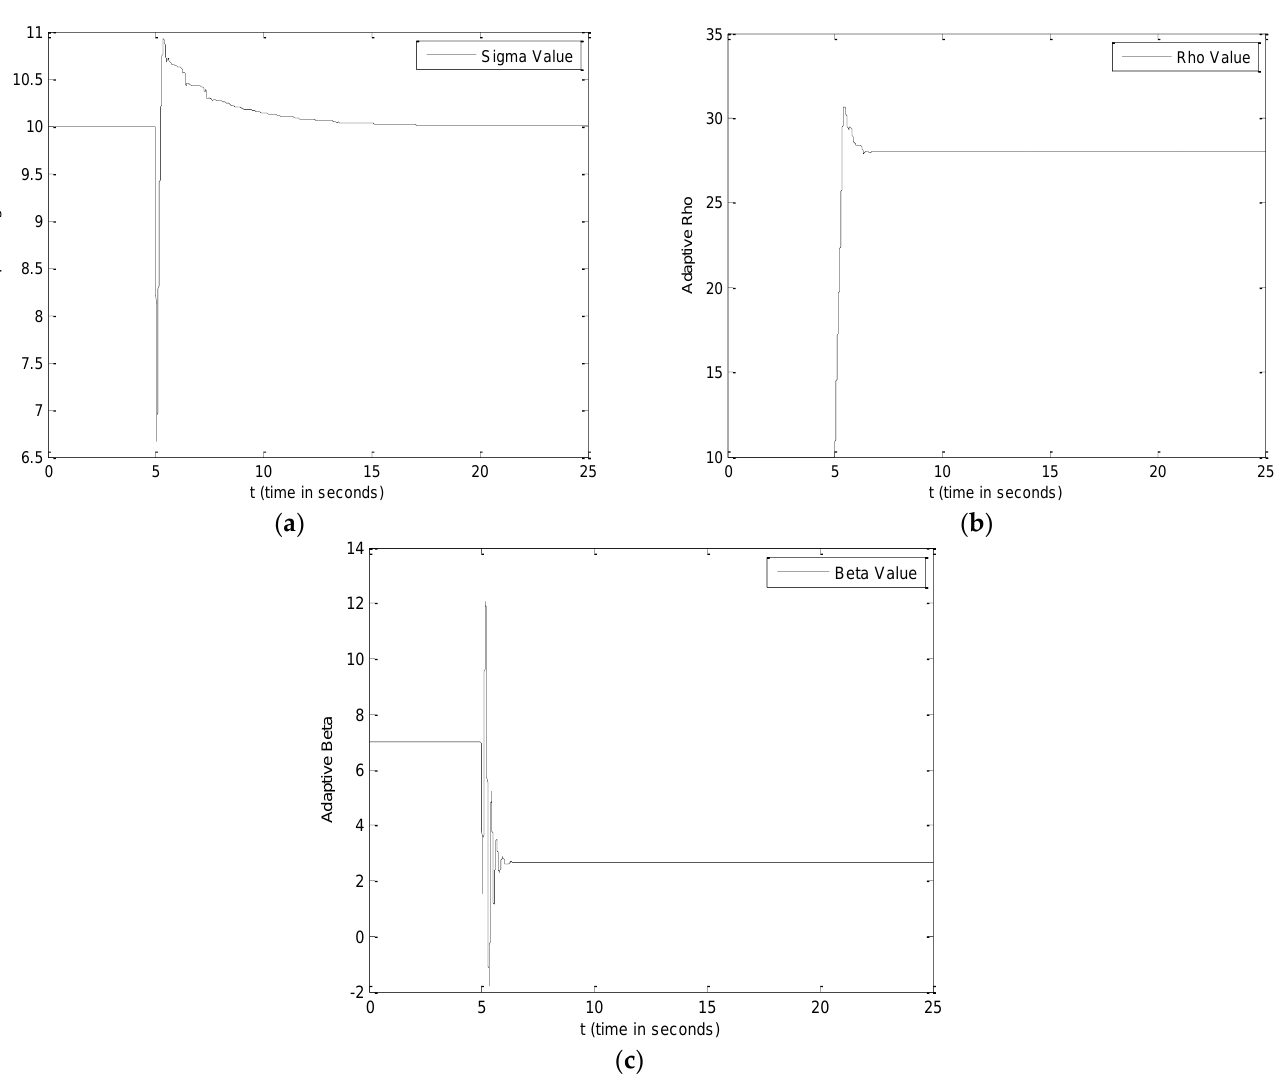
Figure 15. Graphs of anti-synchronization ( a ) σ , ( b ) ρ and ( c ) β values of slave systems with α i = 0.9, i = 1, 2, and 3, a nd time delay τ = 5 s.